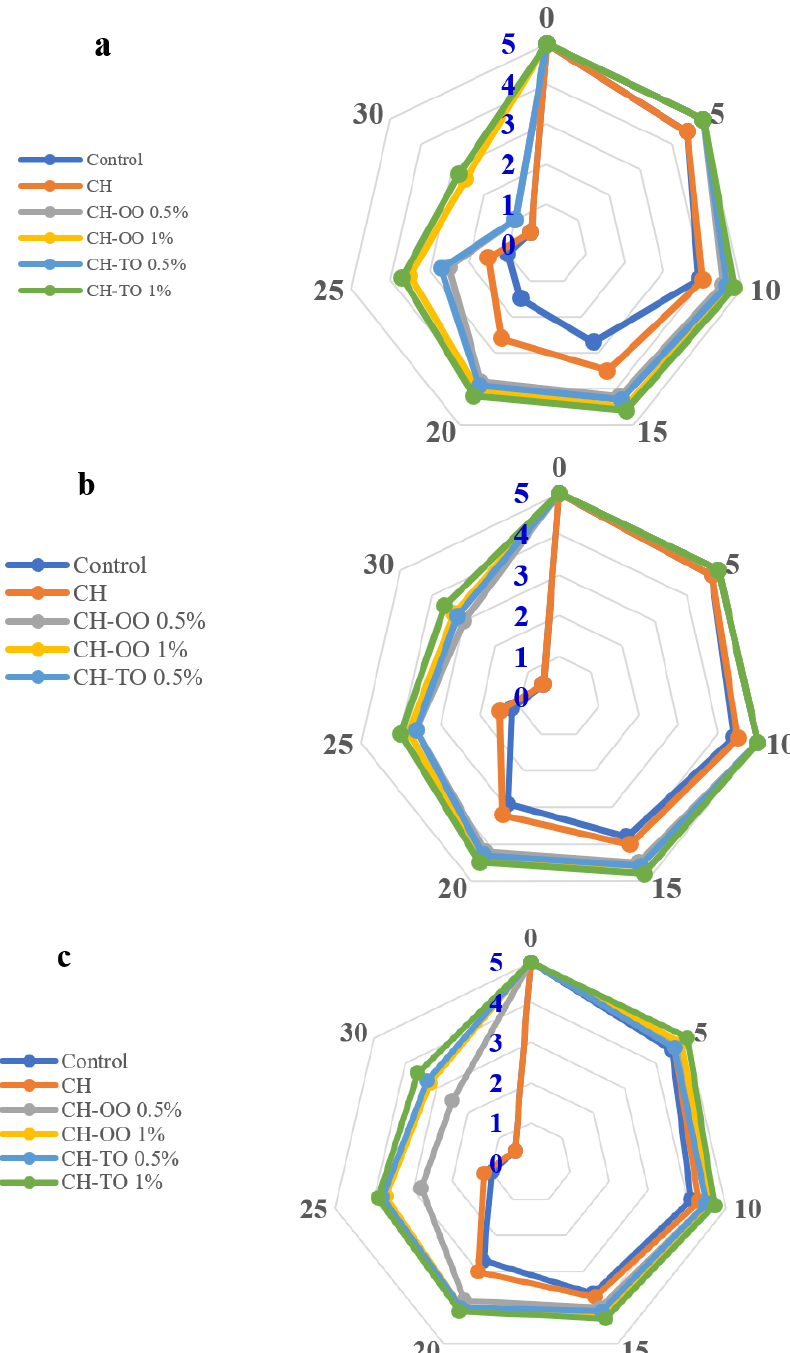
Figure 6. Sensory evaluation parameters i.e., color ( a ), odor ( b ), and overall acceptability ( c ) of beef meat with chitosan-based film incorporated oregano (OO) and thyme (TO) essential oils during storage at 4 °C (n = 12). Control: without film and oil; CH: chitosan; CH − OO 0.5%: chitosan+ oregano oil 0.5% CH − OO 1%: chitosan+ oregano oil 1%, ;CH − TO 0.5%: chitosan+ thyme oil 0.5%; and CH-TO 1%: chitosan+ thyme oil 1%.